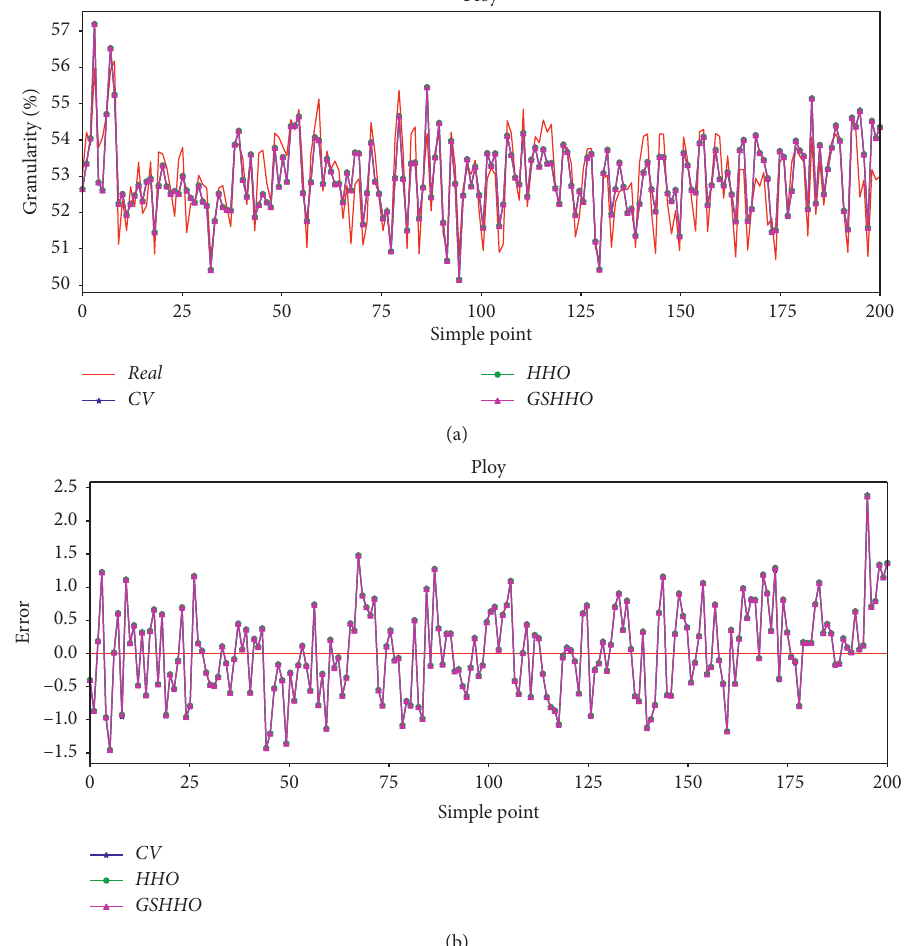
Figure 8: Prediction results under LSSVM model with ploy function. (a) Prediction results under different LSSVM models. (b) Prediction errors under different LSSVM